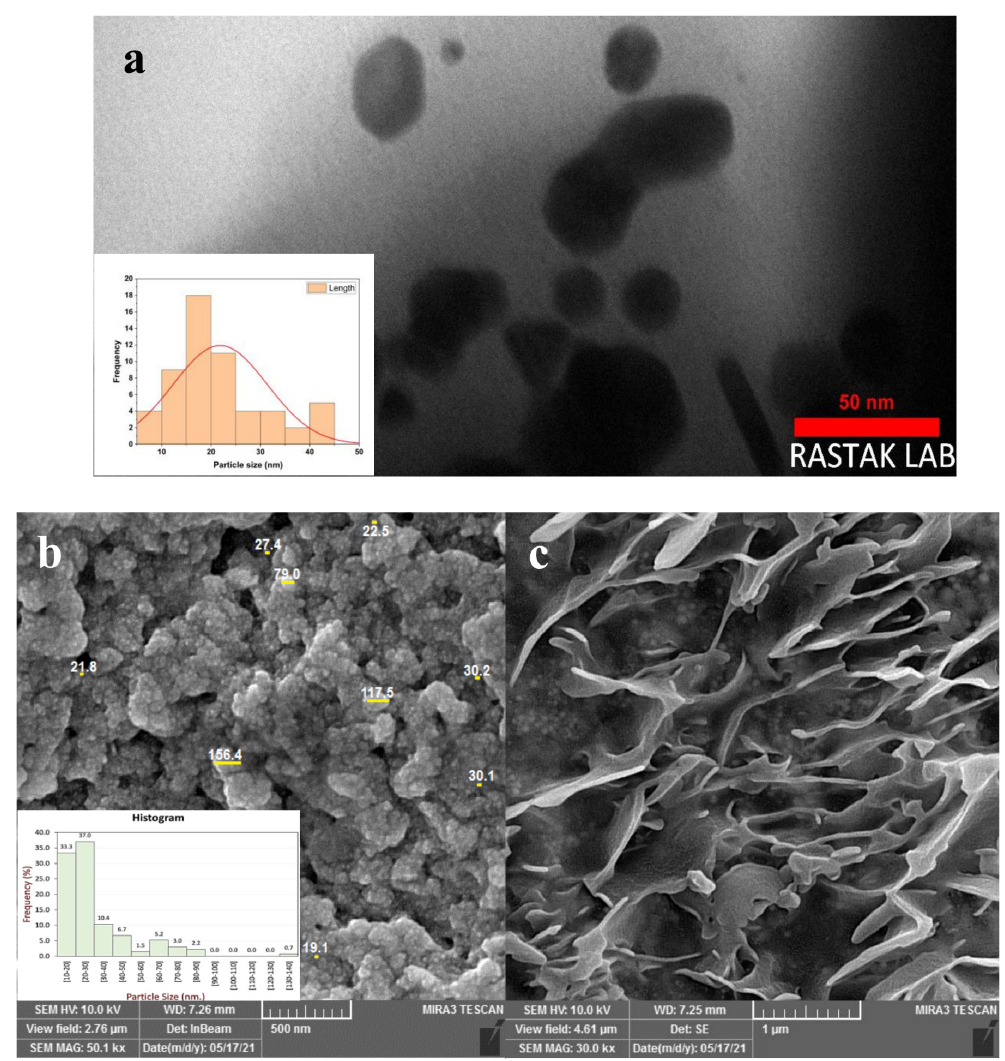
Figure 2. ( a ) The TEM image and the histogram reported from TEM image; ( b , c ) the SEM images at 500 nm and 1 µm magnifications and the histogram obtained from image 500 nm magnification. EDX analysis was used to identify atomic compositions of CC-AuNPs, indicating a strong gold signal (2.2 keV) in the biosynthesized CC-AuNPs (Figure 3). In addition, the presence of C (0.27 keV), O (0.52 keV), and other impurities in the EDX spectra confirmed phytochemicals existing in the CC-extract [7,31,32]. The findings of Liu et al. proved the formation of AuNPs (by Zooglea ramigera ) with EDX signals at 2.2 keV and 8.5 keV, which was similar to our result [33].